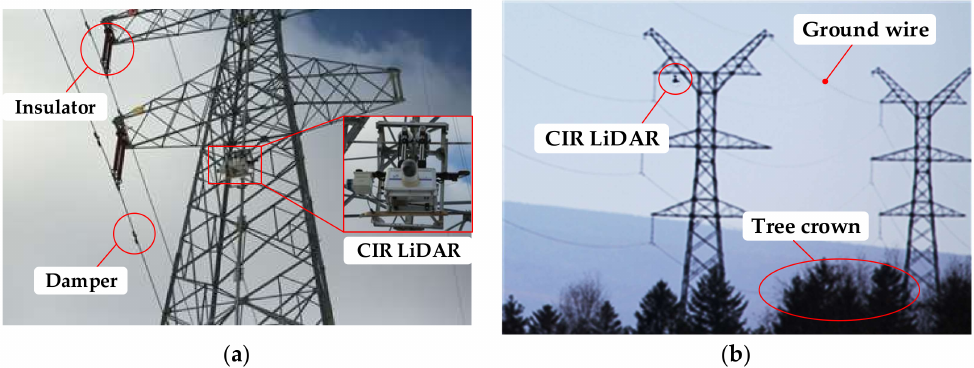
Figure 2. The image of collection data of CIR LiDAR system: ( a ) close-up image; ( b ) long-distance